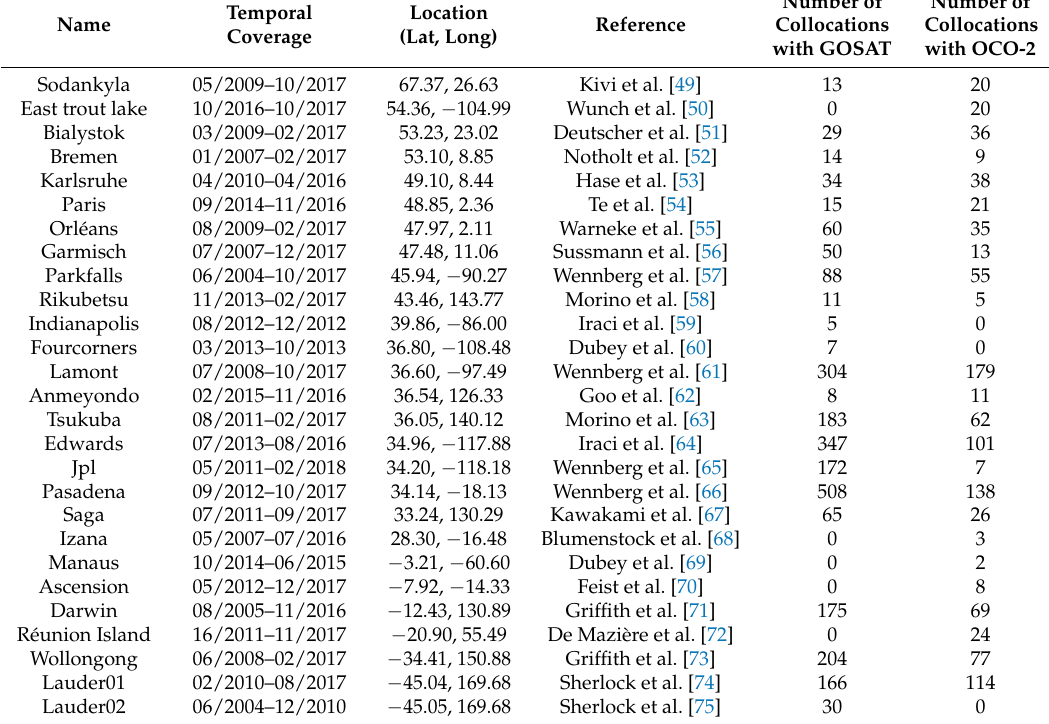
Table 2. Information on the TCCON sites used in the comparison with the GOSAT/ACOS and OCO-2 retrievals. The number of collocations with both satellites using the method described in Section 2.5 is also